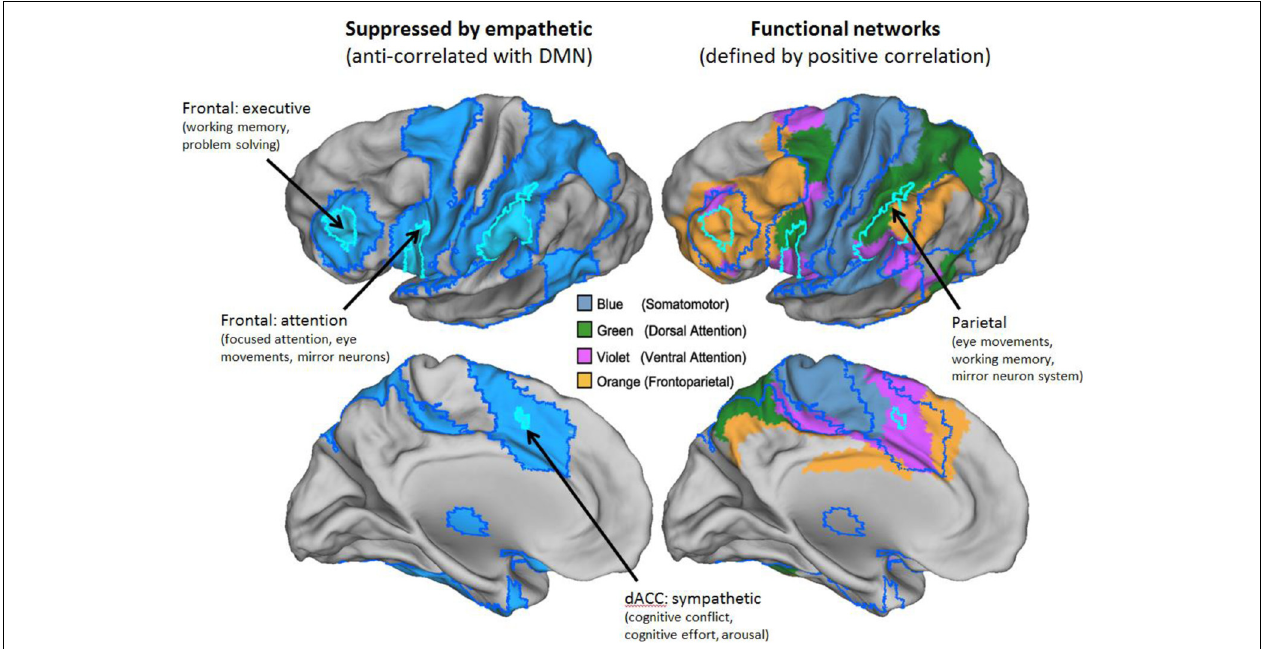
FIGURE 3 |The task-positive network (TPN). TheTPN representation based on anti-correlations corresponds to multiple networks defined by positive correlations. Left panels show just theTPN derived from anti-correlations in blue. Right panels show networks derived byYeo etal. (2011) with substantial